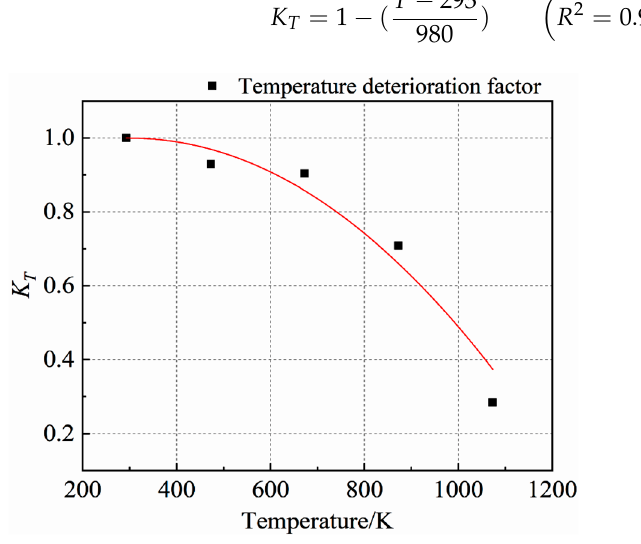
Figure 13. Fitting curve of K T test data of the high-temperature deterioration factor.